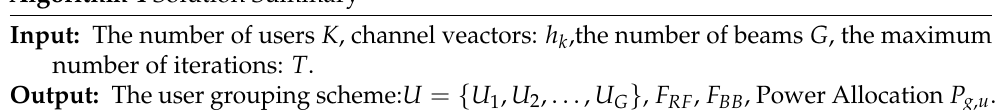
Algorithm 4 Solution